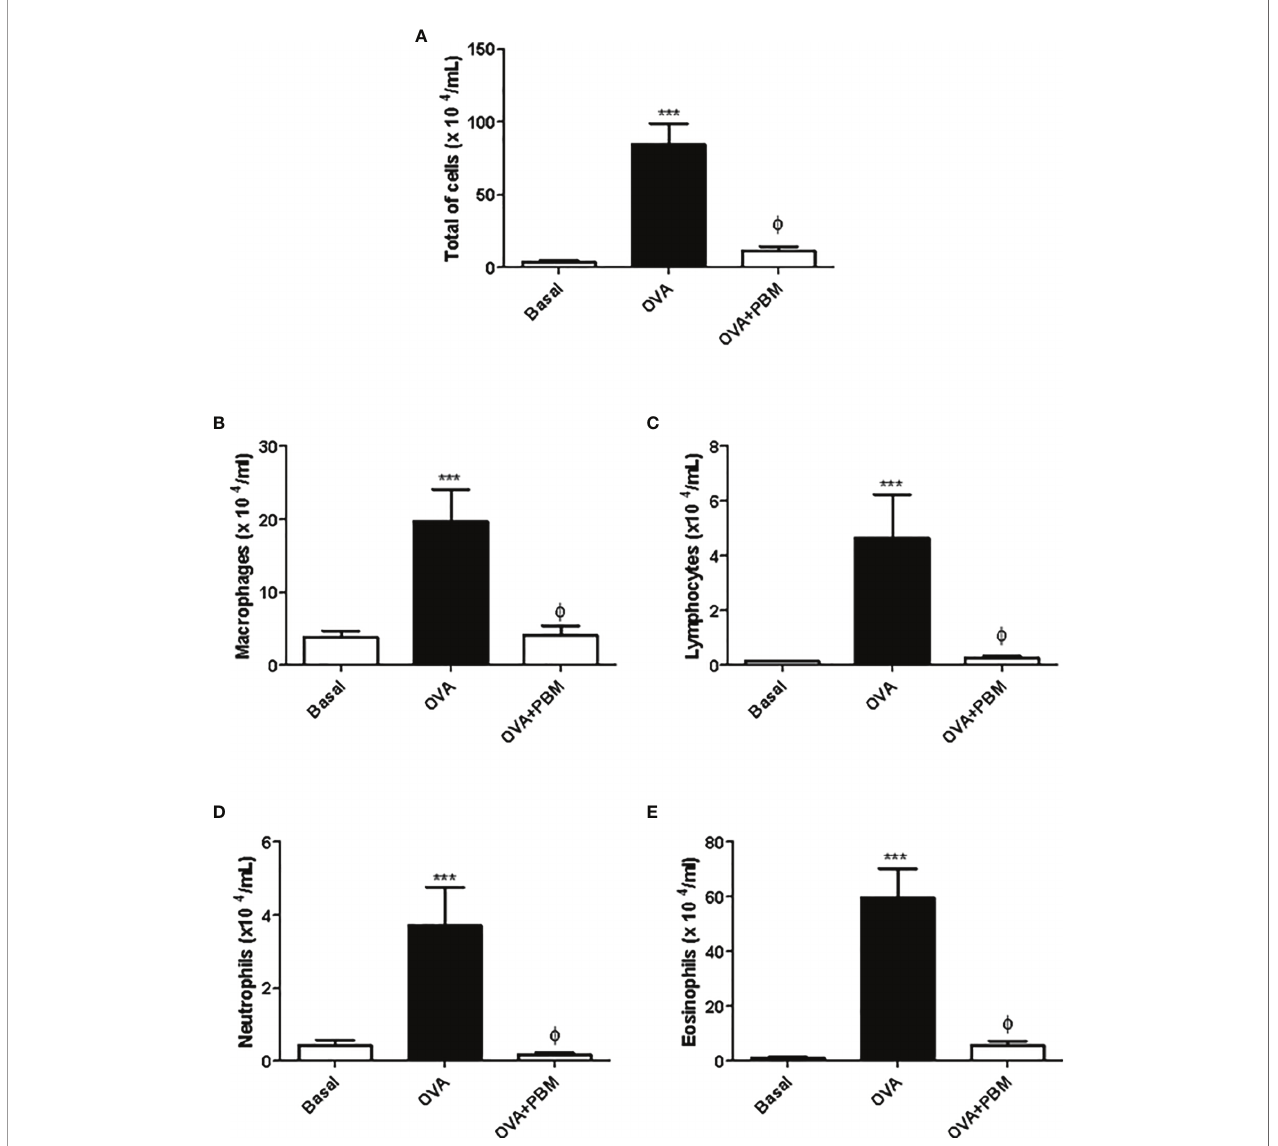
FIGURE 1 | Photobiomodulation on the in fl ux of in fl ammatory cells to the lung. In (A) , the total number of cells, (B) macrophages, (C) lymphocytes, (D) neutrophils, and (E) eosinophils recovered in the bronchoalveolar lavage (BAL) 24 h after the last challenge. Basal group n = 5; OVA group n = 7; PBM group n = 5; OVA+ PBM n = 8. Two independent sets of experiments were carried out. Data represent mean ± standard error (SEM). *** p < 0.001 in relation to the Basal group. f p < 0.001 in relation to the OVA